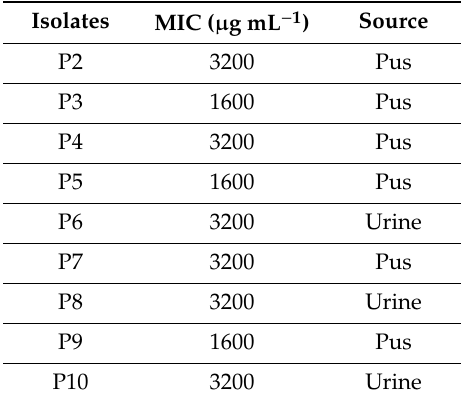
Table 1. MIC values of BM-ZnO NPs against P. aeruginosa (PAO1 and clinical